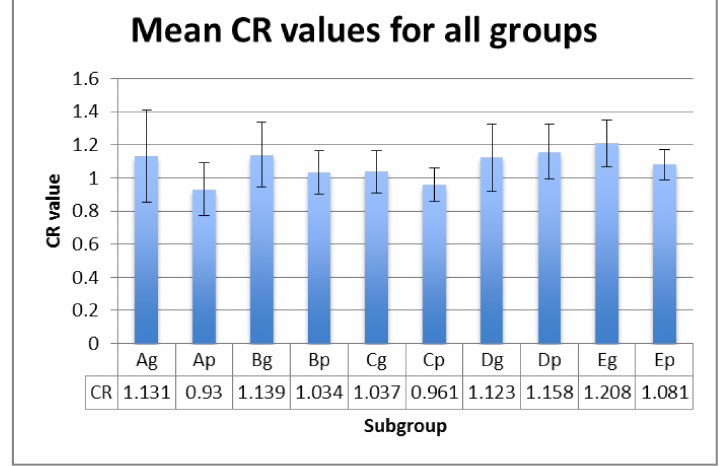
Figure 2. CR values (mean ± SD) for all tested groups.